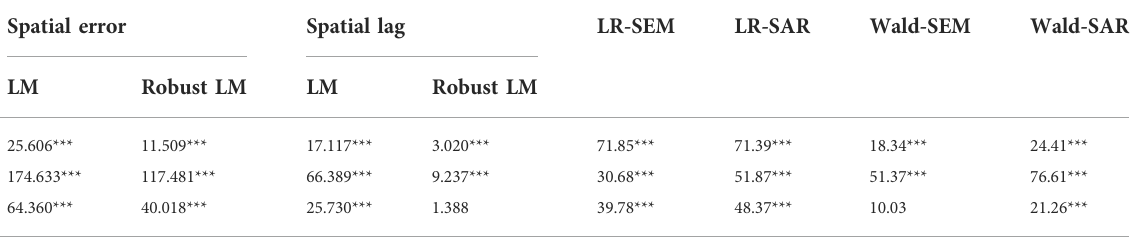
TABLE 3 LM test, LR test and Wald test results.